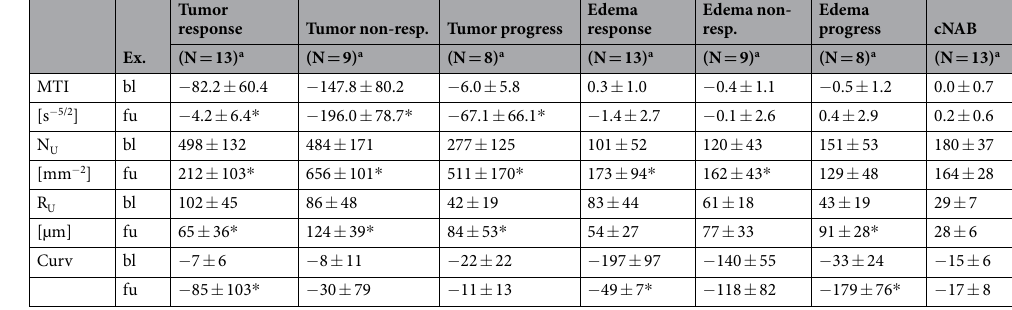
Table 1. VAM biomarker values in three different tumor areas and peritumoral edema. Values are mean values ± standard deviation. a In parentheses: number of patients. * Values marked with an asterisks are significant (P < 0.05) different to the value at the baseline examination. Note: MTI = microvessel type indicator; N U = microvessel density; R U = microvessel radius; Curv = curvature of the long-axis of the VHL; Exam. = examination; bl = baseline; fu = 3-month follow-up, cNAB = contralateral normal appearing